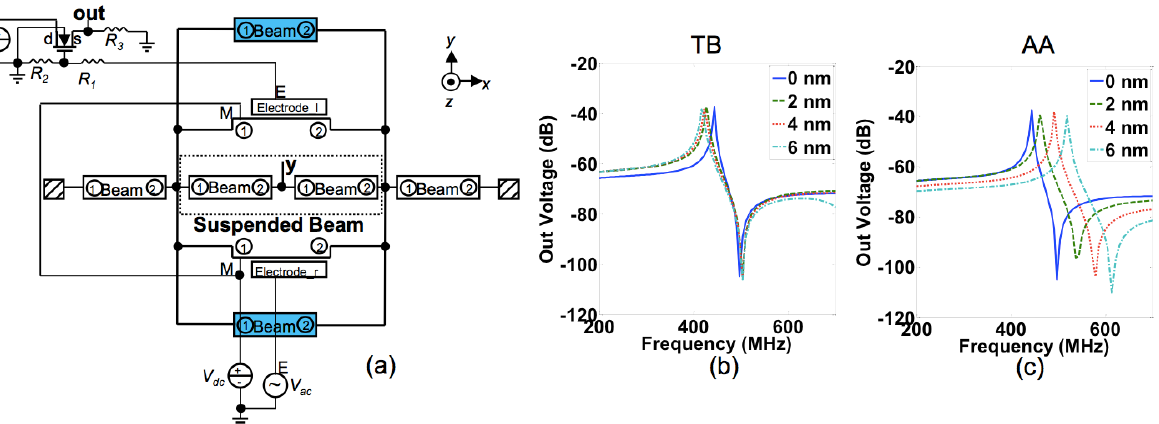
Figure 7. ( a ) The hybrid circuit model of the in-plane resonant suspended gate field-effect-transistor (IP RSG-FET) sensor with the added coating layers for modeling the top and bottom (TB) and all-around (AA) configurations in Architect. The output voltage of the IP RSG-FET sensor versus frequency for different thicknesses of the coating layer in Architect for: ( b ) the TB configuration and ( c ) the AA configuration.